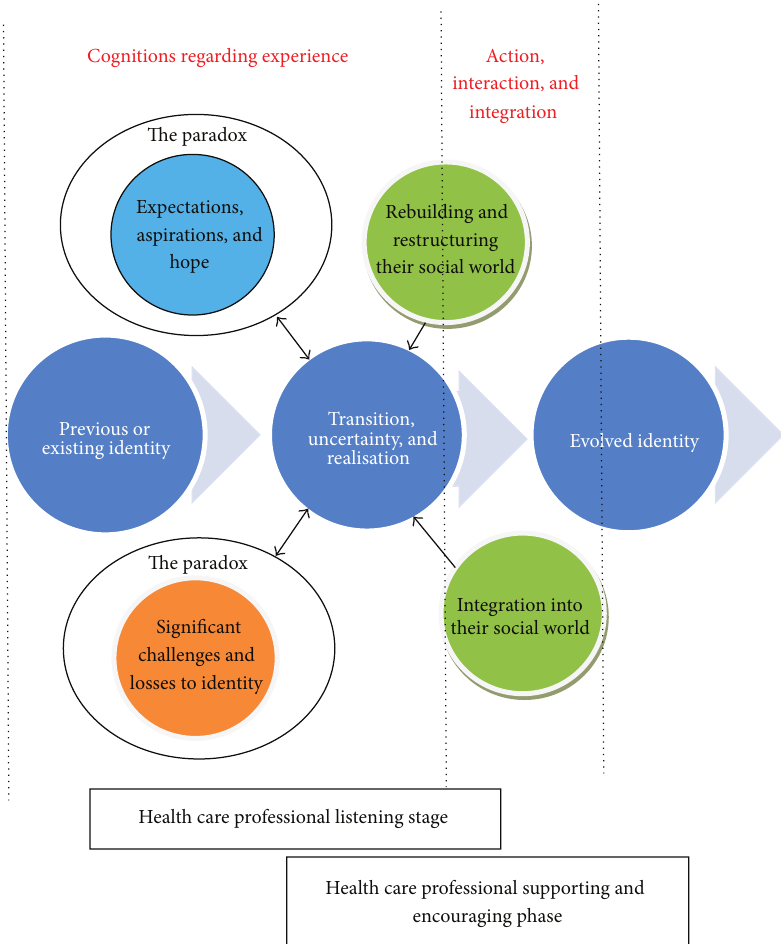
Figure 2: The model of transitional experiences within stroke